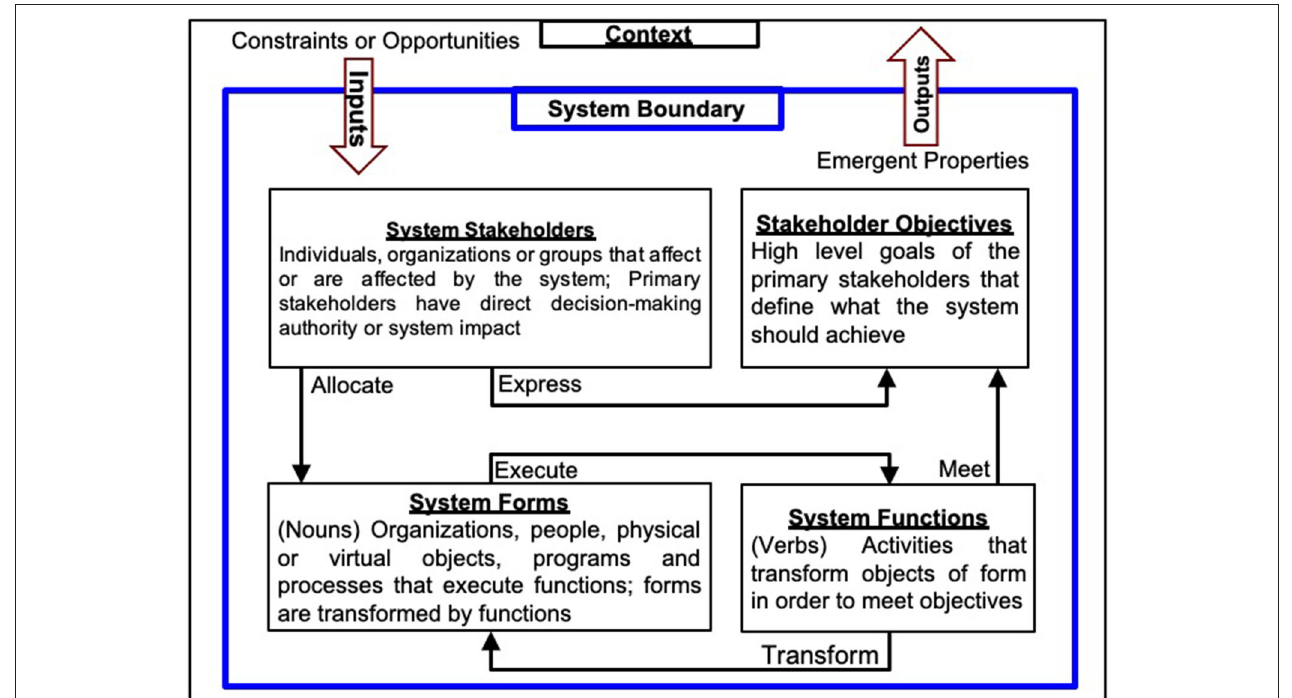
FIGURE 1 | The Systems Architecture Framework adapted by Wood can be used to design or evaluate a system created by humans with strong links to the environment and technology. Credit: Danielle Wood.